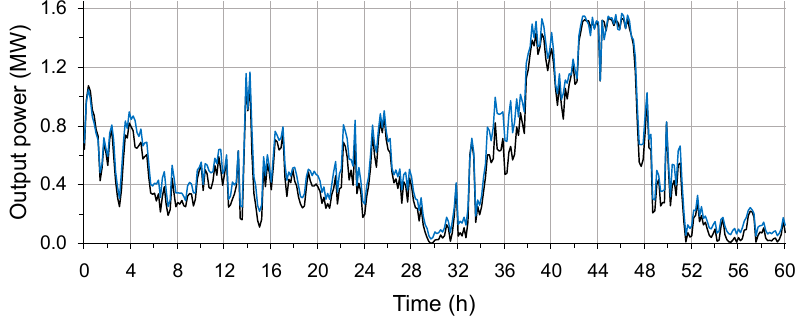
Figure 8. Simulated (black line) and measured (blue line) output power of the wind turbine General Electric GE 1.5sl over a period of 60 h with a temporal resolution of 10 min.